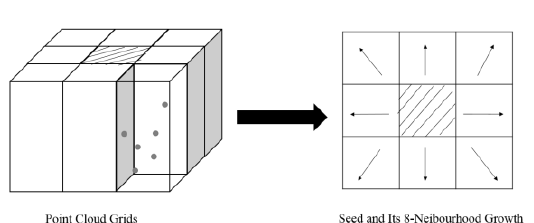
Figure 6: Explanation of 8-Neighbourhood growth method based on grids.